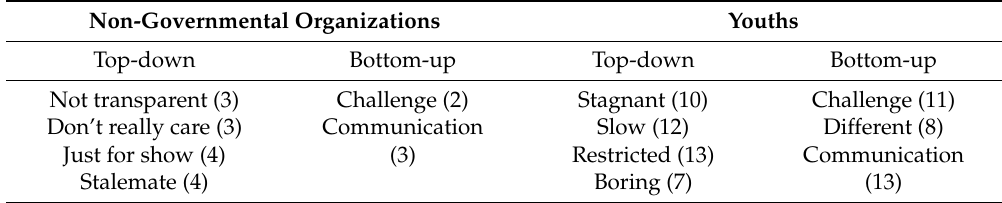
Table 3. NGOs and youths’ terms associated with top-down and